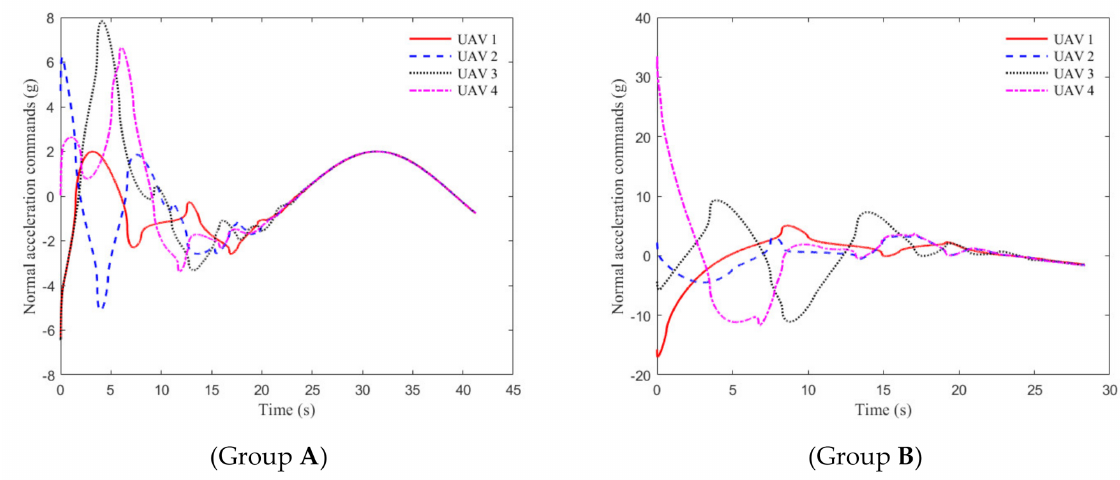
Figure 10. Normal overload